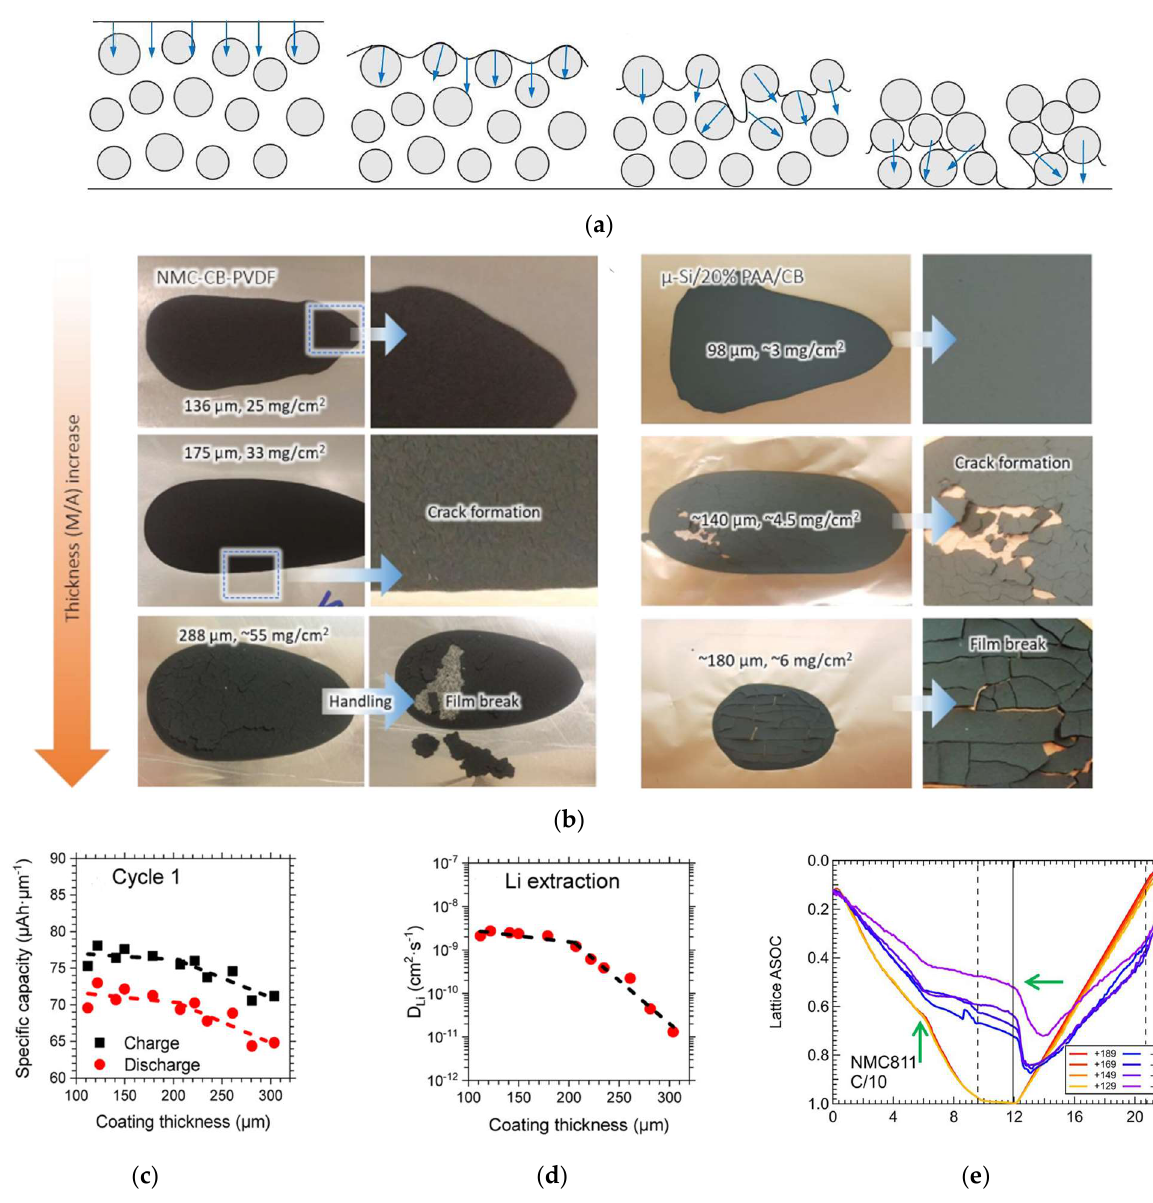
Figure 3. ( a ) Illustration of the drying process [41]. ( b ) Cracks in NMC electrodes (NMC811:PVDF:CB = 90:5:5, wt.%) and μ−Si electrodes (μ-Si:PAA:CB = 80:10:10, wt. %) [46]. ( c ) First cycle thickness−normalized specific capacity as a function of electrode thickness [47]. ( d ) D Li+ as a function of electrode thickness [47]. ( e ) An inhomogeneity in different thicknesses across an NMC811 electrode during the charging and discharging process [50].